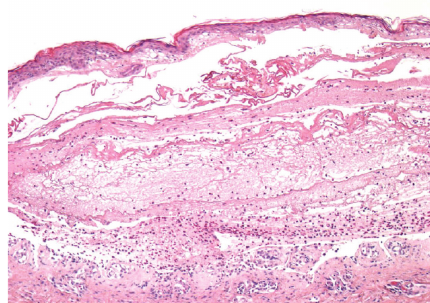
Figure2:Histologydemonstratingsubepidermalblisters.Theinter- face between epidermis and dermis layers is infiltrated by densely populatedinflammatorycellsaroundthebasementmembranezone, including eosinophils (haematoxylin and eosin stain (magnification × 50)). Figure kindly provided by the Histopathology Department, Royal Berkshire Hospital, Reading,